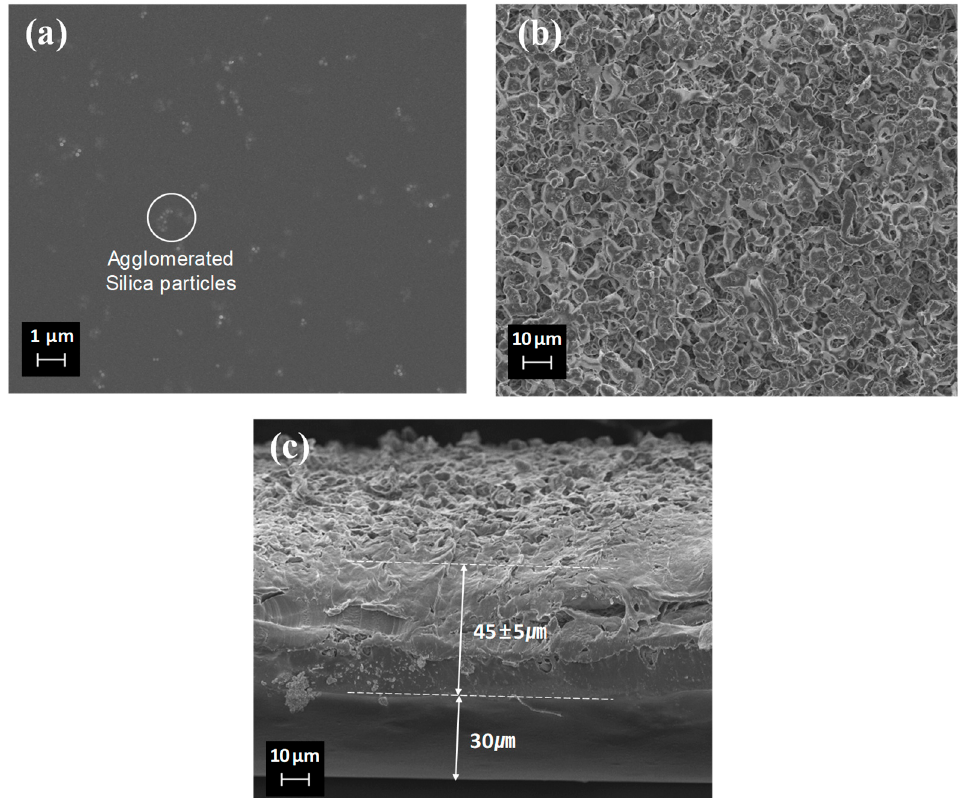
Figure 4. Scanning electron microscope (SEM) images of the membrane sample. ( a ) Hydrophobic membrane side with agglomerated silica nanoparticles of 5 wt% and ( b ) the polyamide support ( c ) a membrane cross-section showing the thicknesses of each layer.